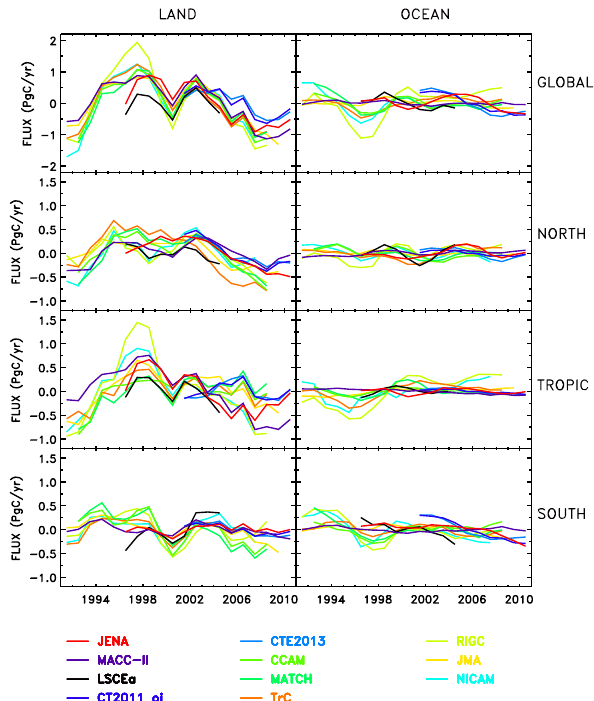
Fig. 7. Smoothed annual mean anomalies (smoothing window of 3yr) carbon exchange from the individual participating inversions. Shown here are the natural land “fossil-fuel-corrected” (first col- umn) and natural ocean (second column) carbon exchange aggre- gated over the Globe, north ( > 25 ◦ N), tropics (25 ◦ S–25 ◦ N) and south ( < 25 ◦